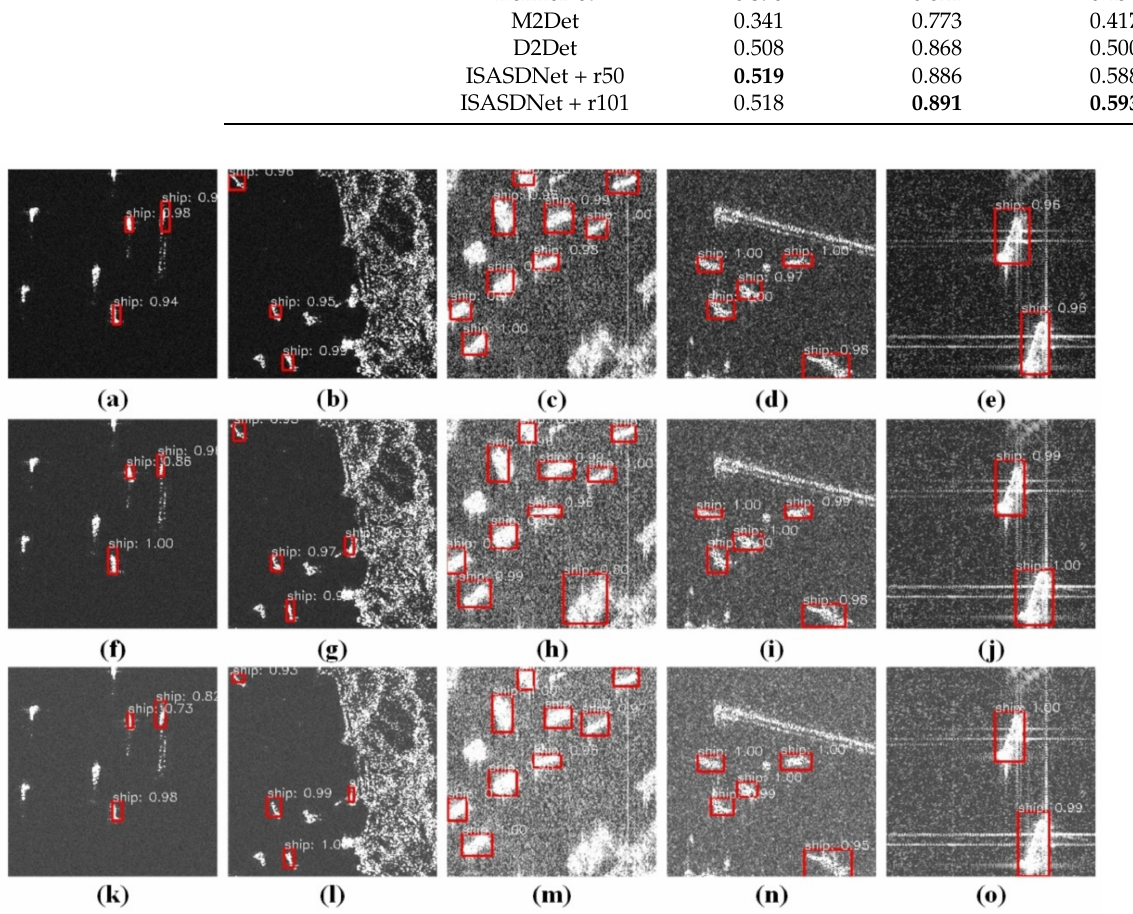
Figure 16. The results of ISASDNet under different noises. ( a – e ) The first row of the images is added with Gaussian noise with a mean value of 0 and a variance of 0.1. ( f – j ) The second row of the images is added with Gaussian noise with a mean value of 0 and a variance of 0.2. ( k – o ) The third row of the images is added with Gaussian noise with a mean value of 0 and a variance of